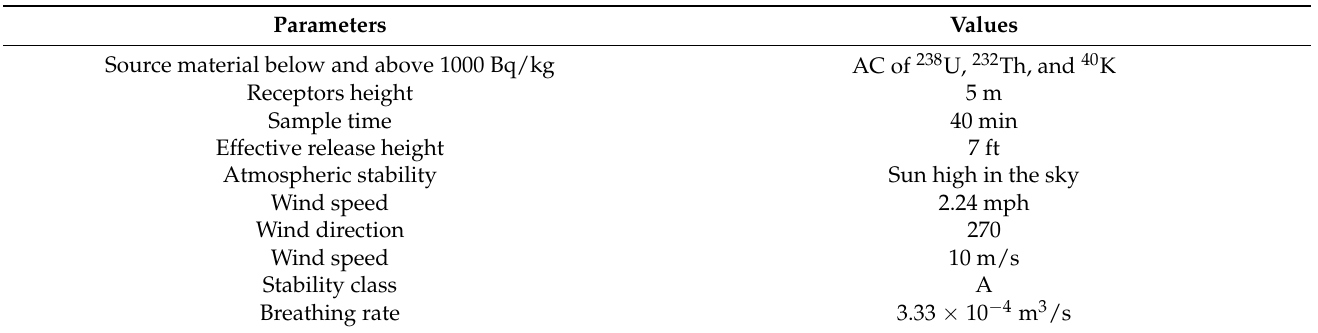
Table 5 summarizes all input parameters considered in calculating radiological dose from the incineration of CPs containing NORMs. The HotSpot module considered in this study was the general fire module. Table 5. Input values used in HOTSPOT.